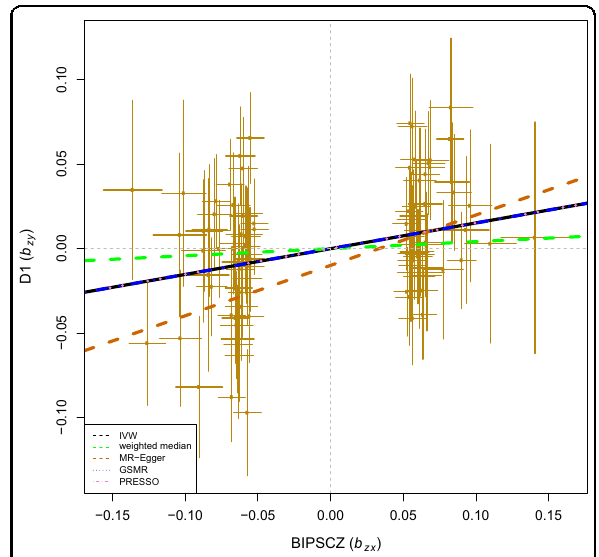
Fig. 1 Scatter plot of MR analyses using several models to examine causal relationships of BIP-SCZ genetic liability on self-reported COVID-19. The fi ve models applied in the current manuscript are all depicted. Lines in black, green, brown, blue, and purple represent results for fi xed-effect IVW, weighted median, MR- Egger, GSMR, and MR-PRESSO models using 96 instruments. Neither GSMR nor MR-PRESSO identi fi ed any instrument outliers. Hence, the MR-PRESSO result was same as the IVW result, which was almost the same as the GSMR result, resulting in overlapping lines in the graph. Error bars represent effect size standard errors.